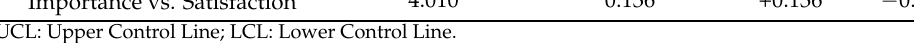
Table 4. Index Values of the Overall Performance Evaluation Matrix PEM. EvaluationIndex Value Performance Importance vs. Satisfaction 4.010 0.136 +0.136 −